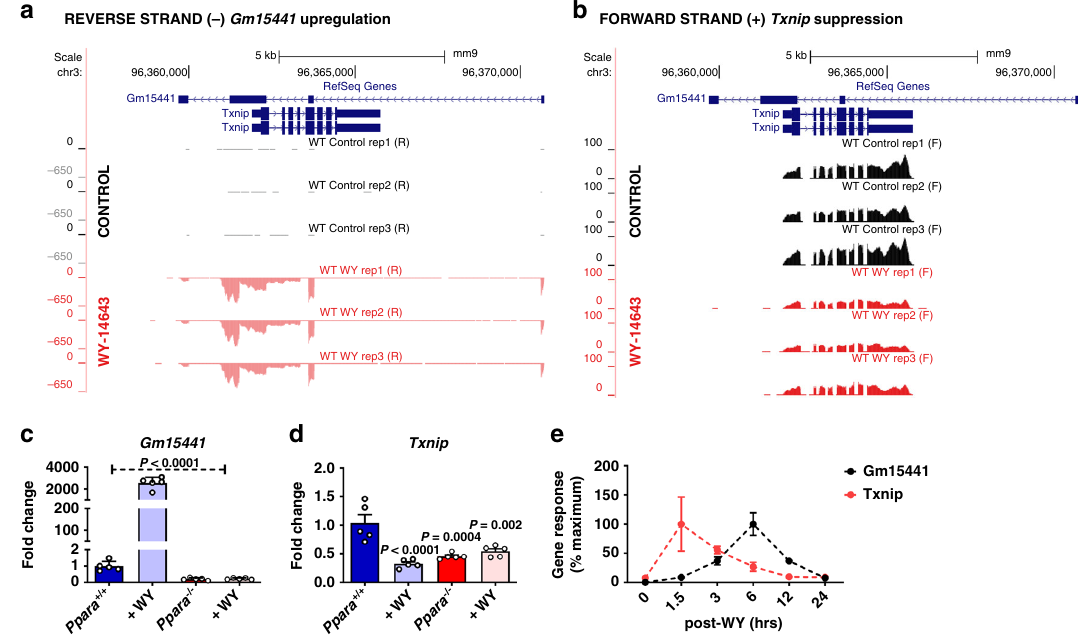
Fig. 2 Txnip and lncRNA Gm15441 are inversely regulated following PPAR α activation. Wild-type ( Ppara + / + ) mice were treated with WY-14643 and stranded RNA-seq was performed on total liver mRNA. a Expression of the antisense lncRNA Gm15441 is strongly upregulated. b Expression of the protein- coding Txnip mRNA is downregulated. Shown are the changes in expression of Gm15441 ( c ), and Txnip ( d ), mRNAs in Ppara + / + and Ppara − / − mice treated with WY-14643, or vehicle control, for 48 h, determined by qRT-PCR. e Time course for changes in expression of Gm15441 and Txnip mRNA over a 24 h period following treatment with WY-14643 by gavage, determined by qRT-PCR. The maximum response of Txnip mRNA was seen at 1.5 h and for Gm15441 was seen at 6 h. Each data point represents the mean ± SD for n = 5 liver samples. Adjusted p values, provided in the panels, as determined by ANOVA with Tukey ’ s multiple comparison correction, two-sided for comparisons to Ppara + / + mice or as shown (dashed horizontal